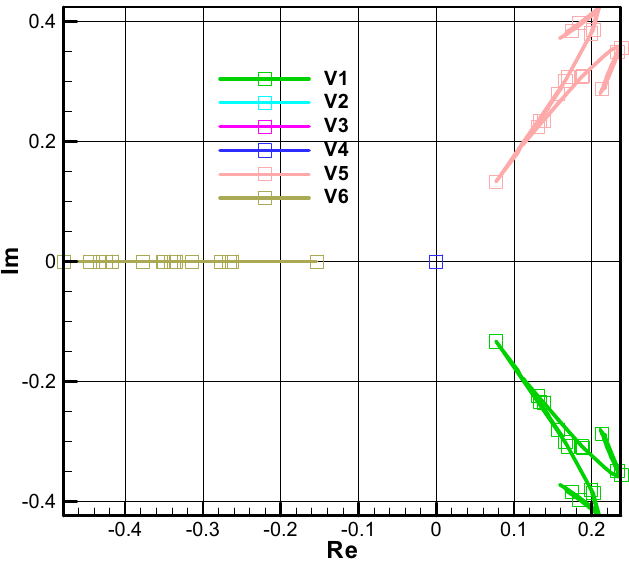
difference consists in the number of eigenvalues. For lateral motion, we have six values; for longitudinal, we only have five values. Figure 10. Eigenvalues of the matrix A-BK for longitudinal motion in ascending/descending evo- Figure 10. Eigenvalues of the matrix A − BK for longitudinal motion in ascending/descending evolution. lution.